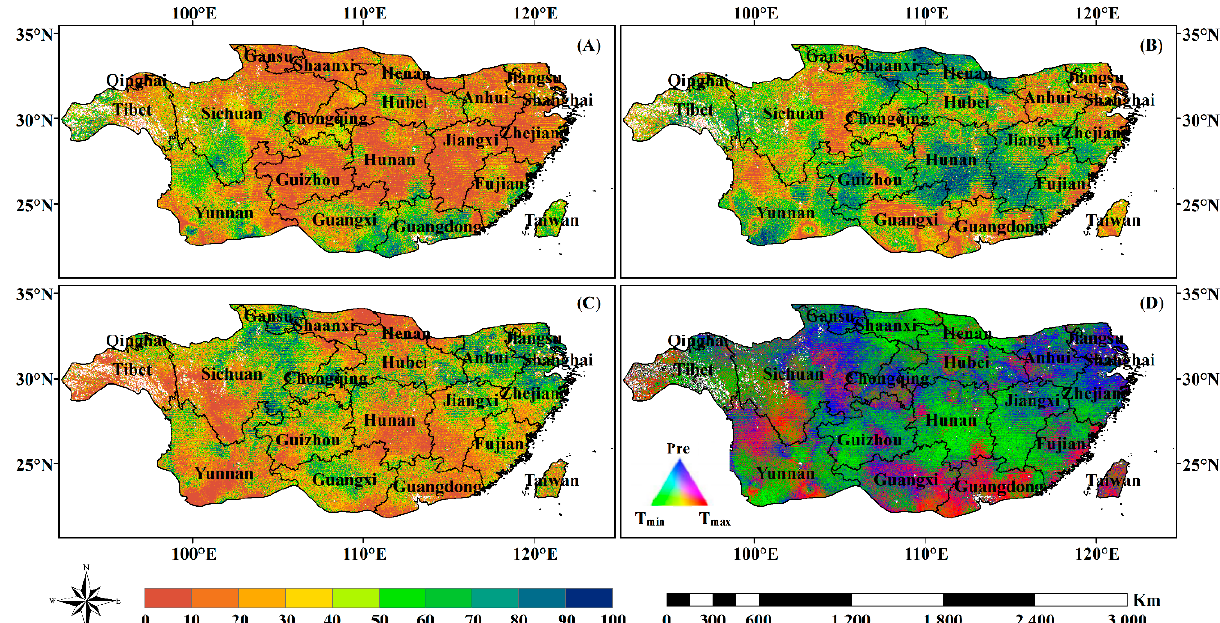
Figure 8. The spatial distribution of the relative contributions of ( A ) Tmax, ( B ) Tmin, and ( C ) Pre to the dynamic variations of subtropical FVC from 2001 to 2018, and ( D ) the spatial distribution of the main contribution factors of climate factors to FVC.